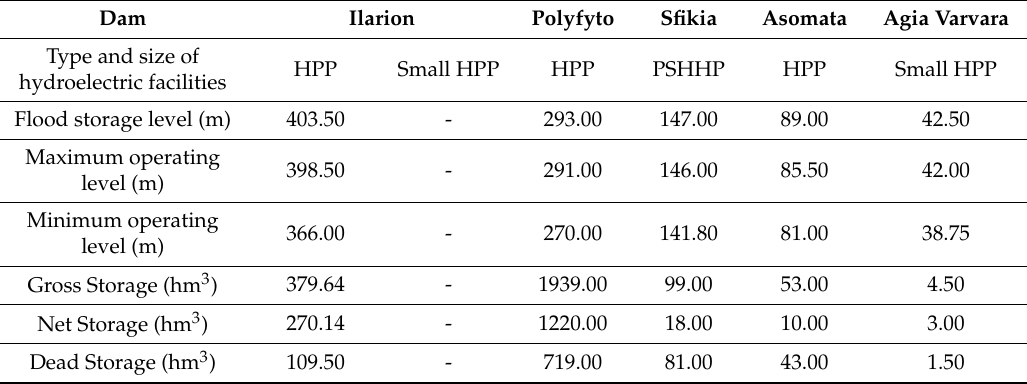
Table 2. Technical characteristics of reservoirs and hydropower stations of the Aliakmon River